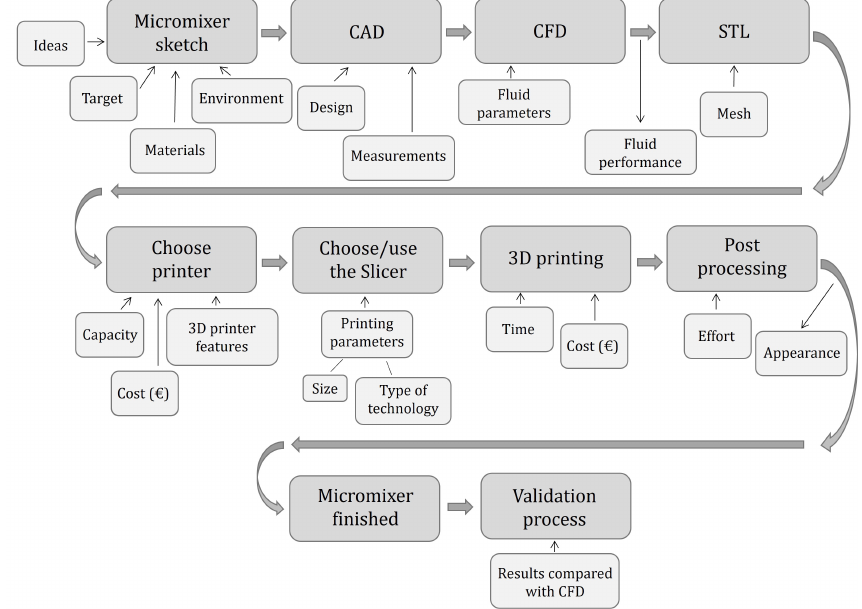
Figure 4. 3D printing diagram assisted with CFD: a general design life